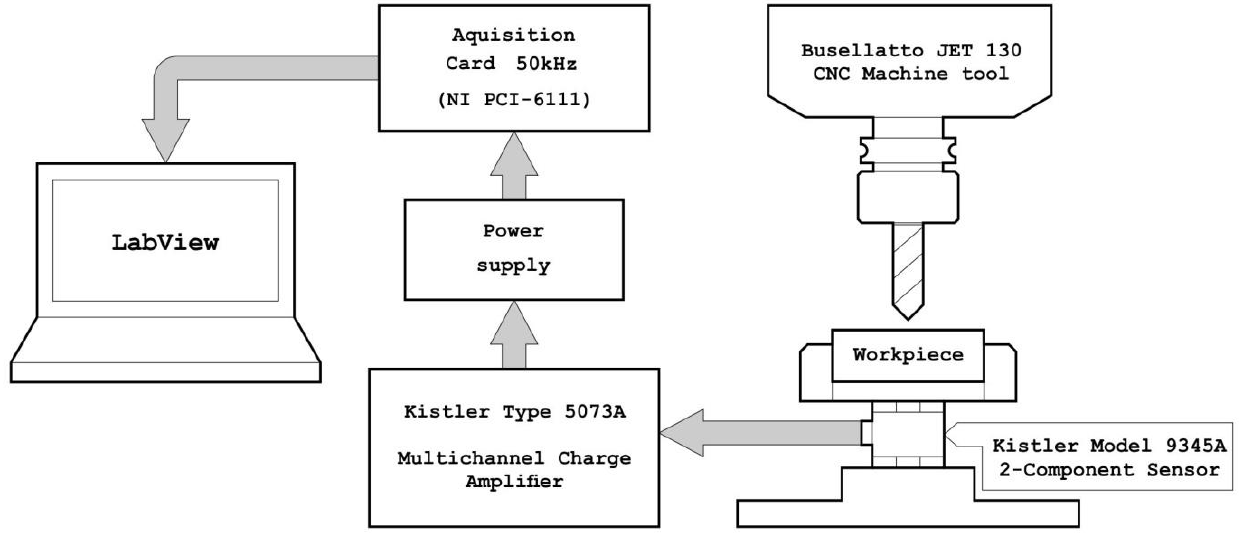
Figure 4. The scheme of the system used for measuring cutting forces during the machining testing.